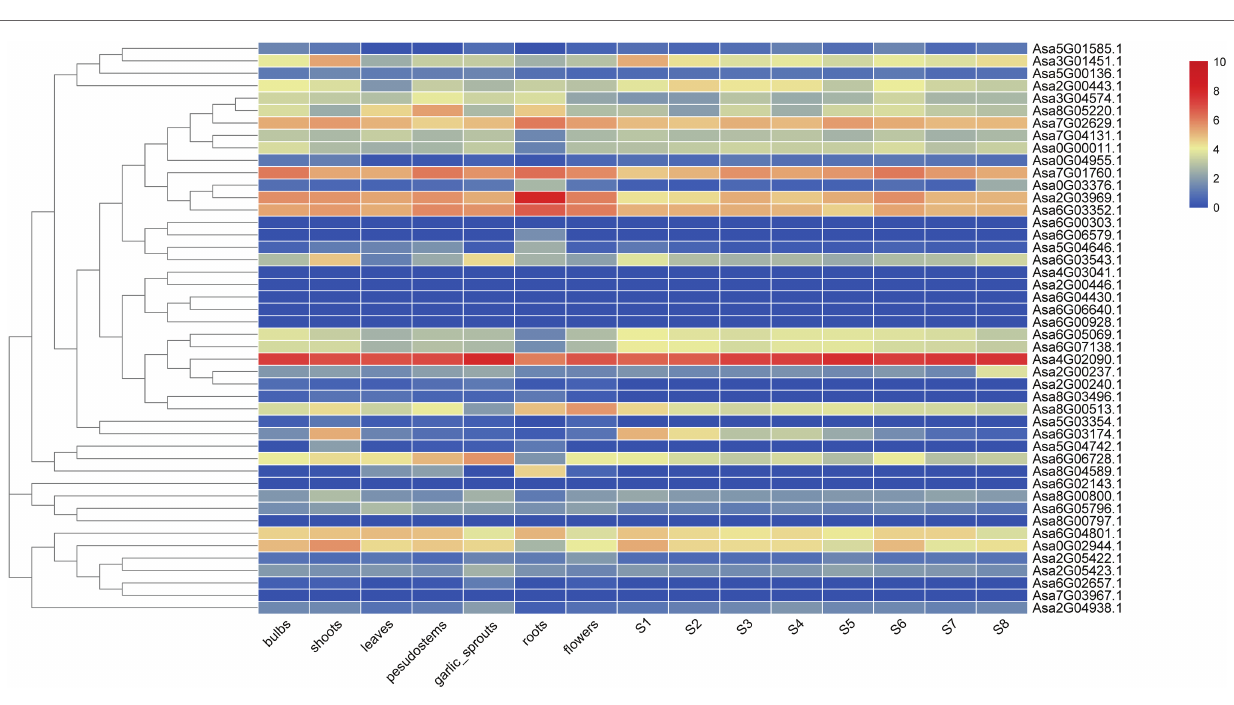
FIGURE 4 | Expression heatmap of garlic GRAS genes in seven tissues and eight bulb growth stages. The colored scale on the right represents the degree of expression, which increases from blue to